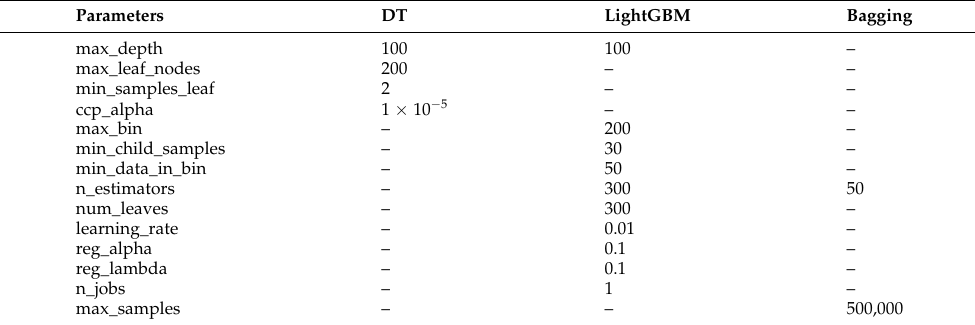
Table 3. Parameter values per classifier. A hyphen denotes that the specific hyperparameter is inapplicable to that classifier.